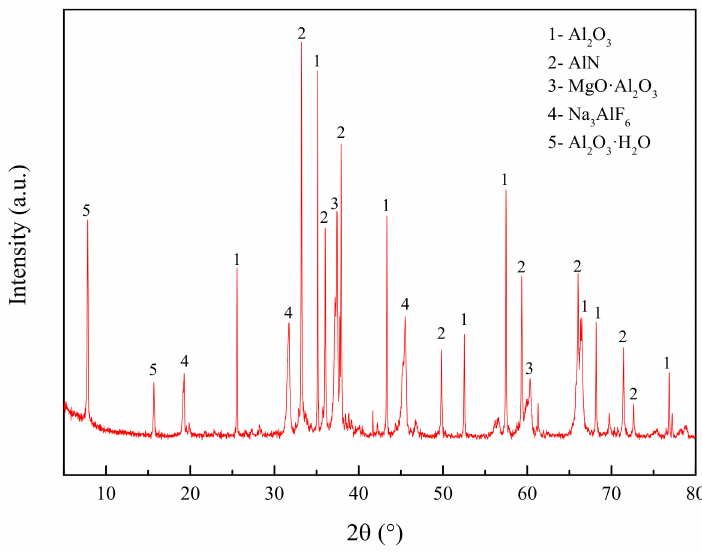
Figure 1. X-ray diffraction phase analysis of the secondary aluminum